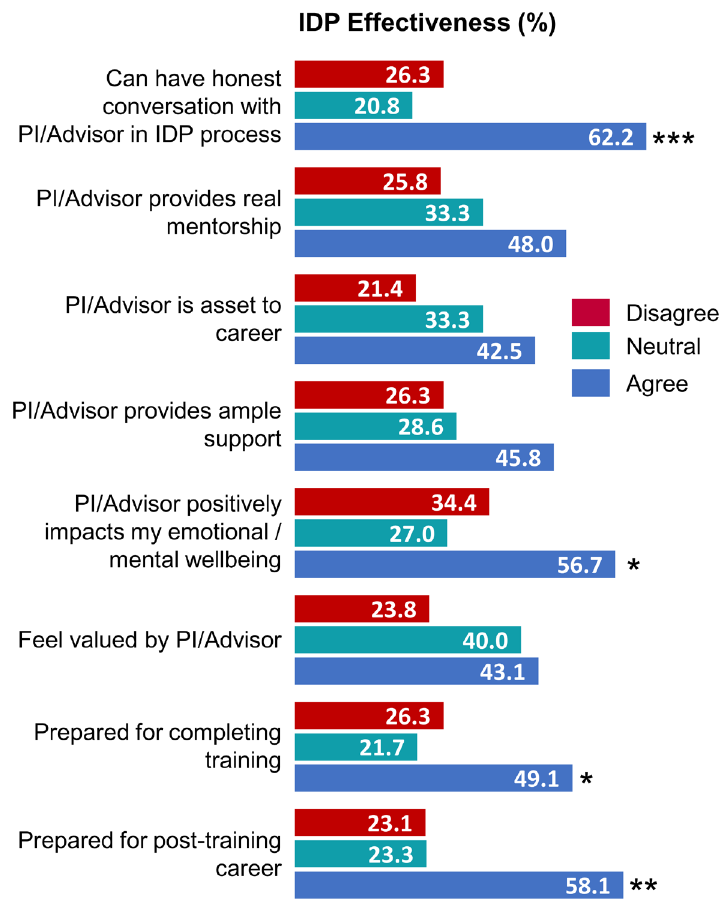
Figure 2. The effectiveness of the Individual Development Plan (IDP). IDP effectiveness was assessed only among the subset of respondents who completed an IDP by determining the univariate associations between the survey variables and the outcome “I Find the IDP Process Helpful to my Career Development.” The Pearson chi-square test was used to measure statistical significance. *** p < 0.001; ** p ≤ 0.01; * p ≤